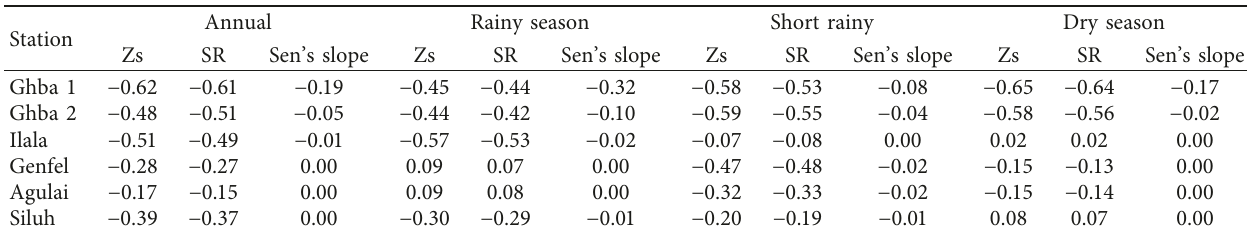
Table 6: Summary of the streamflow trend test using Mann–Kendall and Sen’s